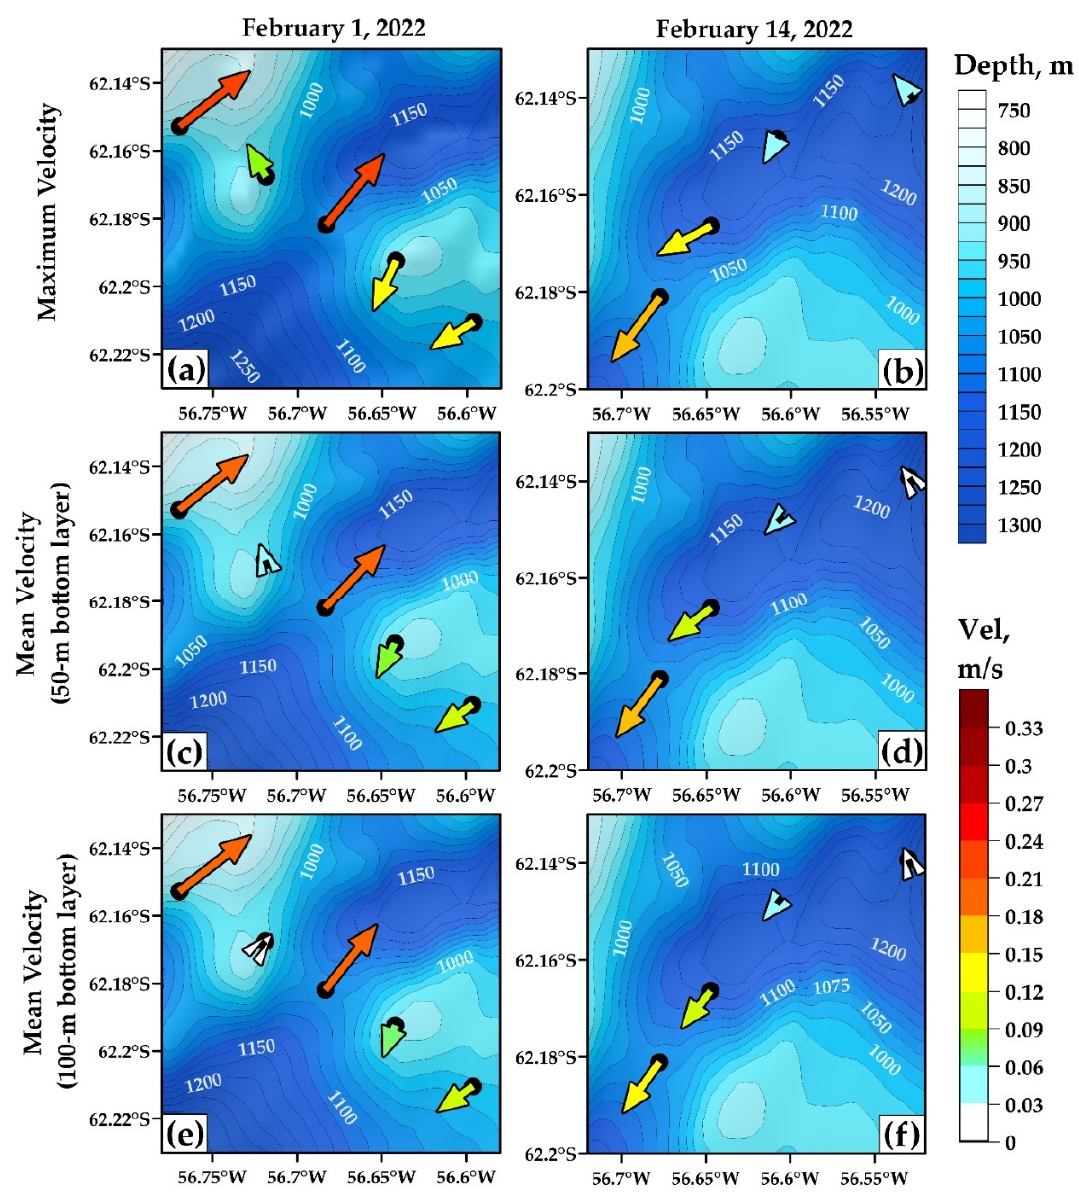
Figure 6. Measured LADCP velocities in the bottom layer over the sill point between the central and eastern basins of the BS. ( a , b ) Maximal velocities averaged ( c , d ) in the 50 m bottom layer and (( e , f )) the 100 m bottom layer. ( a , c , e ) Data measured on 1 February; ( b – f ) measurements performed two weeks later (on 14 February). The magnitude of currents is shown in both the colors and lengths of the arrows; all color and vector scales are the same in all panels. The relief is based on the GEBCO2021